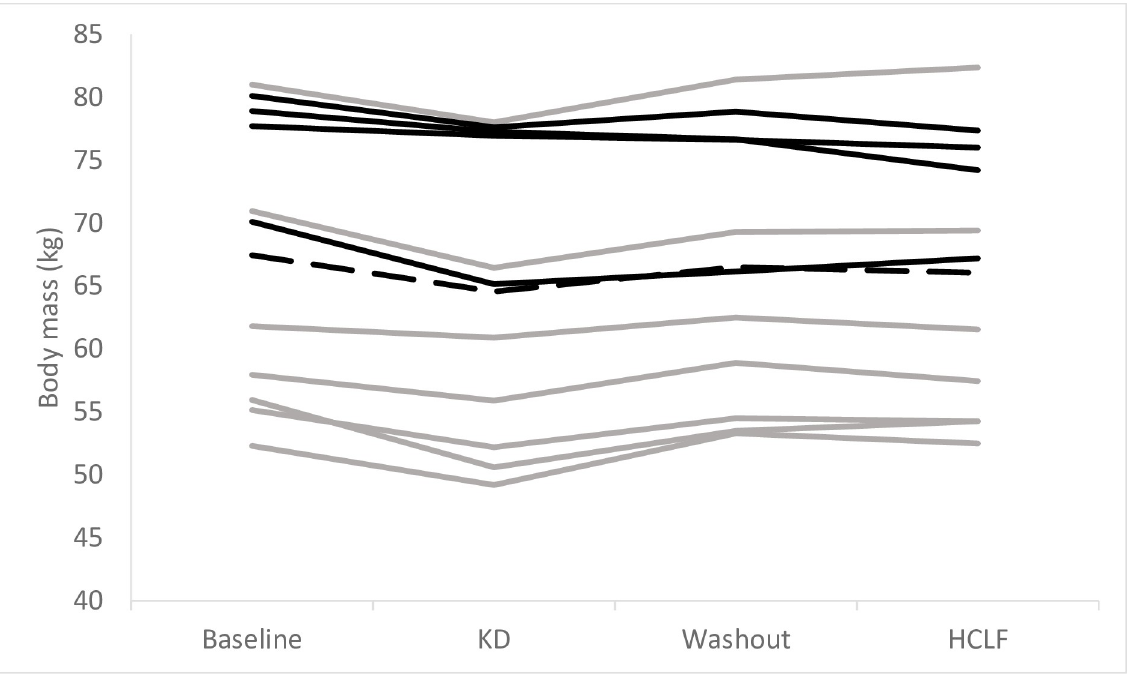
Fig 2. The individual changes in body mass (kg) during the dietary interventions. Solid black lines: participants who did the ketogenic diet (KD) diet first (‘ba’ intervention sequence); Grey lines: participants who did the high-carbohydrate low-fat (HCLF) diet first (‘ab’ intervention sequence); dashed line: mean for all participants.